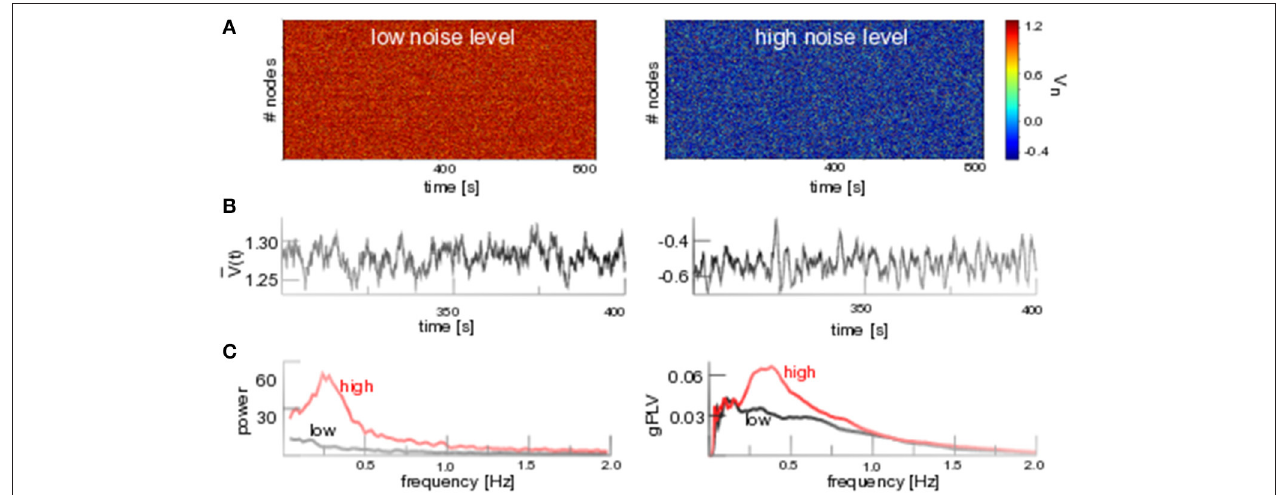
FIGURE 4 | Additive noise induces phase coherent oscillations. (A) D 1 0.1 (low noise level) and D 1 0.8 (high noise level). (B) Temporal snapshot of spatial = = N average ¯ V ( t ) n = 1 V n ( t ) / N for both noise levels. ( C , left) Power spectrum of ¯ V for both noise levels. ( C , right) Global phase coherence gPLV for both noise levels. = Other parameters are D 2 0.5, F 0 2.18, M 0 3.87, H 0 1.7, I 1 1.45, I 2 0.4, c 0.95, N 500, integration time step 1 t P = = = = = = = = Euler-Maryuama integration technique [ 41]. Results for W n are equivalent.